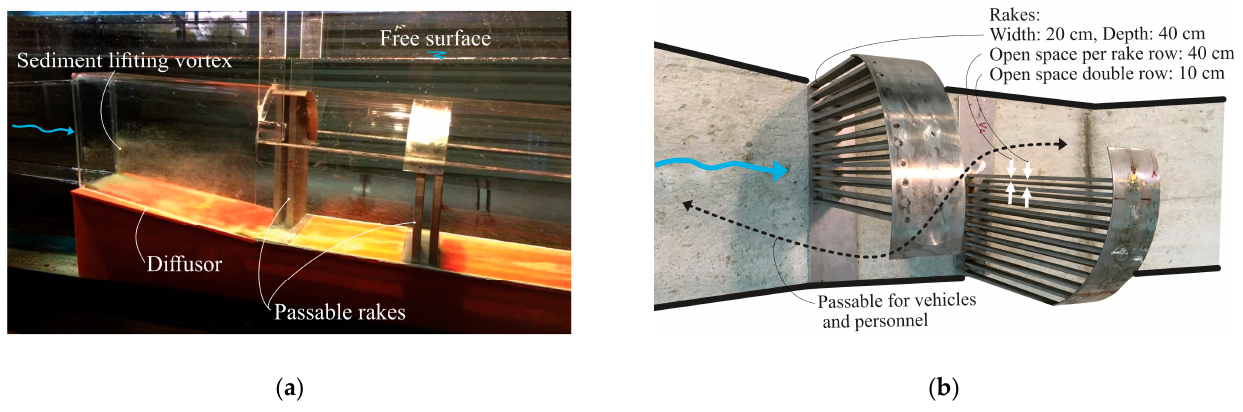
Figure 5. Passable flow calming rake design attempt to mitigate jet effect, downstream diffusor, passable double rake design. ( a ) Side view at 60 l/s discharge and 0.3–1.0 mm sand. ( b ) Top view of inlay rakes in the model with prototype dimensions of rakes.